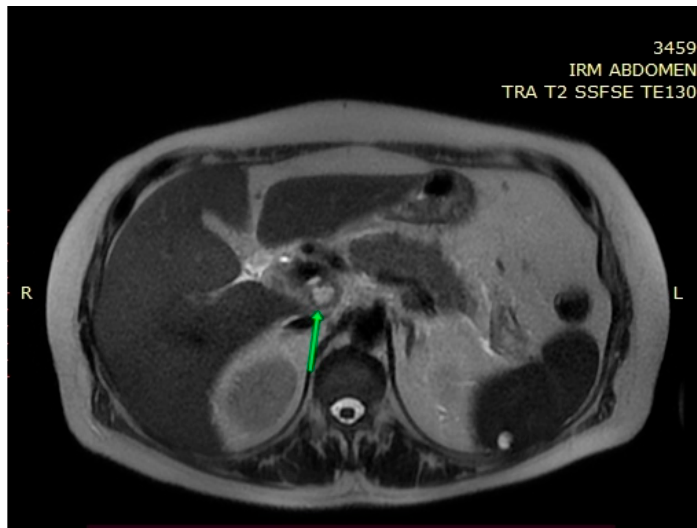
Figure 2. MRI—T2 weighted image: a multicystic cephalopancreatic lesion. Figure 2. MRI − T2 weighted image: a multicystic cephalopancreatic lesion. Figure 2. MRI − T2 weighted image: a multicystic cephalopancreatic lesion.